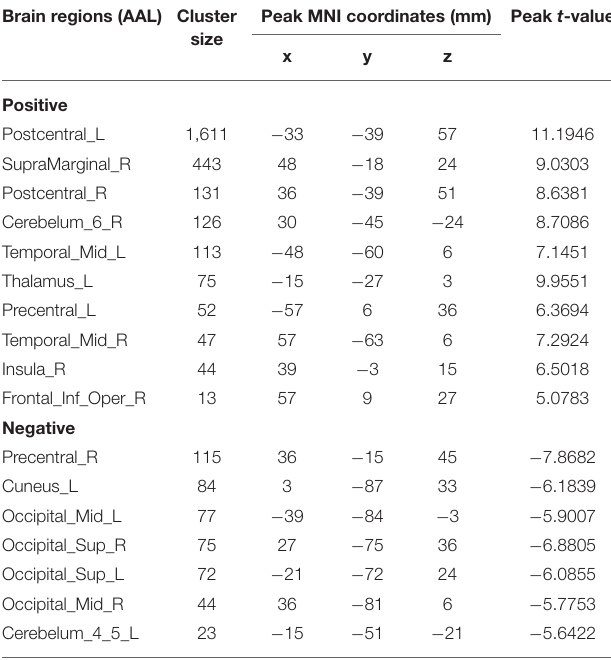
TABLE 2 | Brain regions with significant differences based on a one-sample t -test (two-sided) of SS (voxel-level, FDR-corrected p < 0.001, cluster size > 10 voxels). Brain regions (AAL) Cluster Peak MNI coordinates (mm) Peak t size